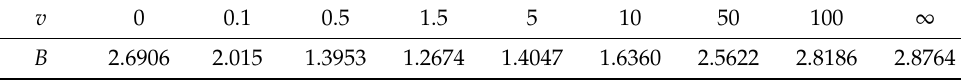
Table 2. Burst ratio for selected values of parameter v .